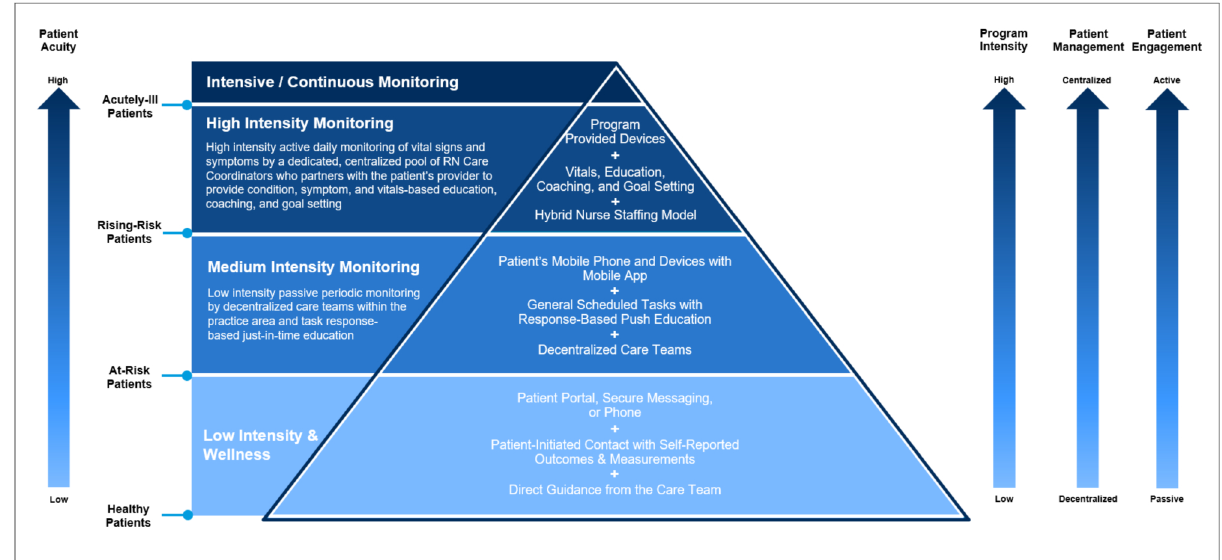
FIGURE 4 Framework for an RPM program with nurse-based care